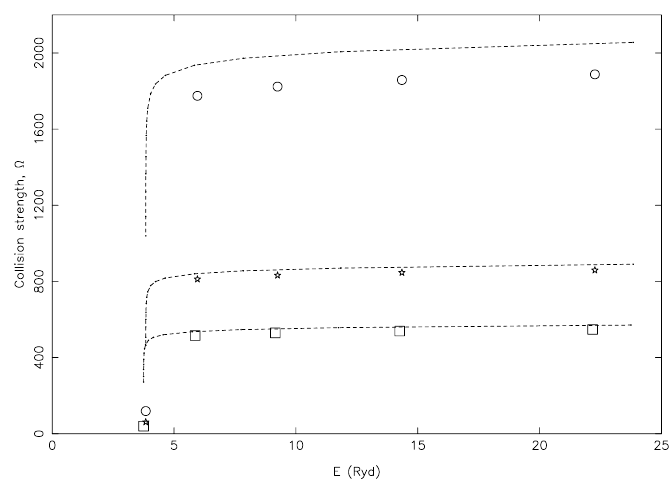
), 21–22 (5f 2 F o –5d 2 D 5/2 ) 5/2 5/2